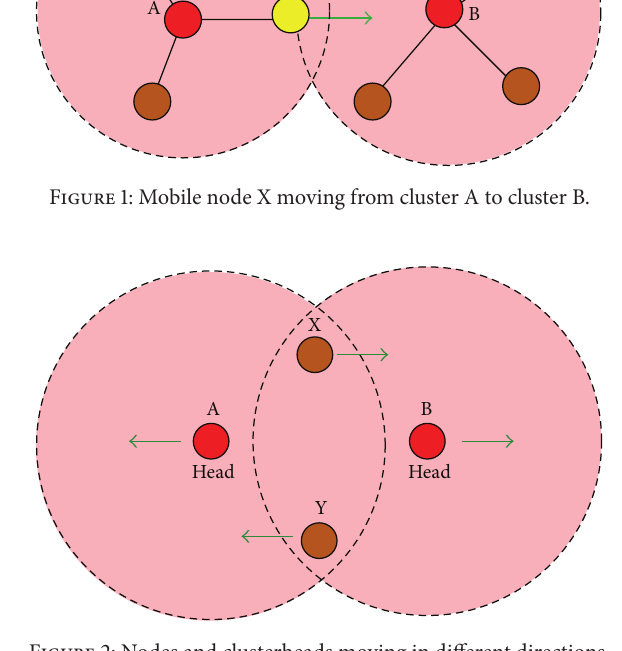
Figure 2: Nodes and clusterheads moving in different